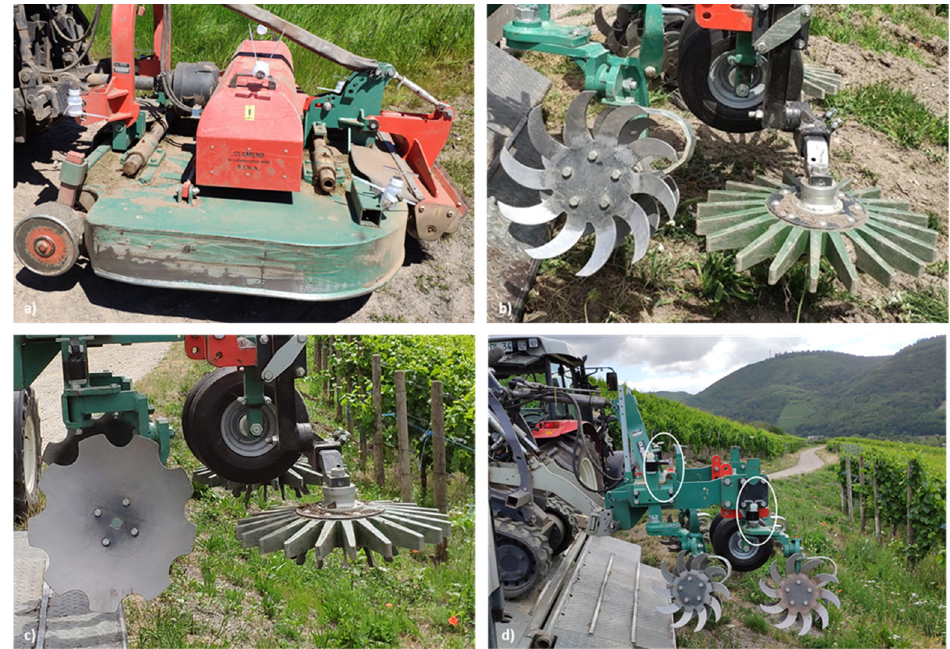
Figure 4. ( a ) Mulcher, ( b ) rotary-star tiller–finger hoe, ( c ) disc plough–finger hoe and ( d ) rotary-star tillers with equipped with MWAC samplers (marked).